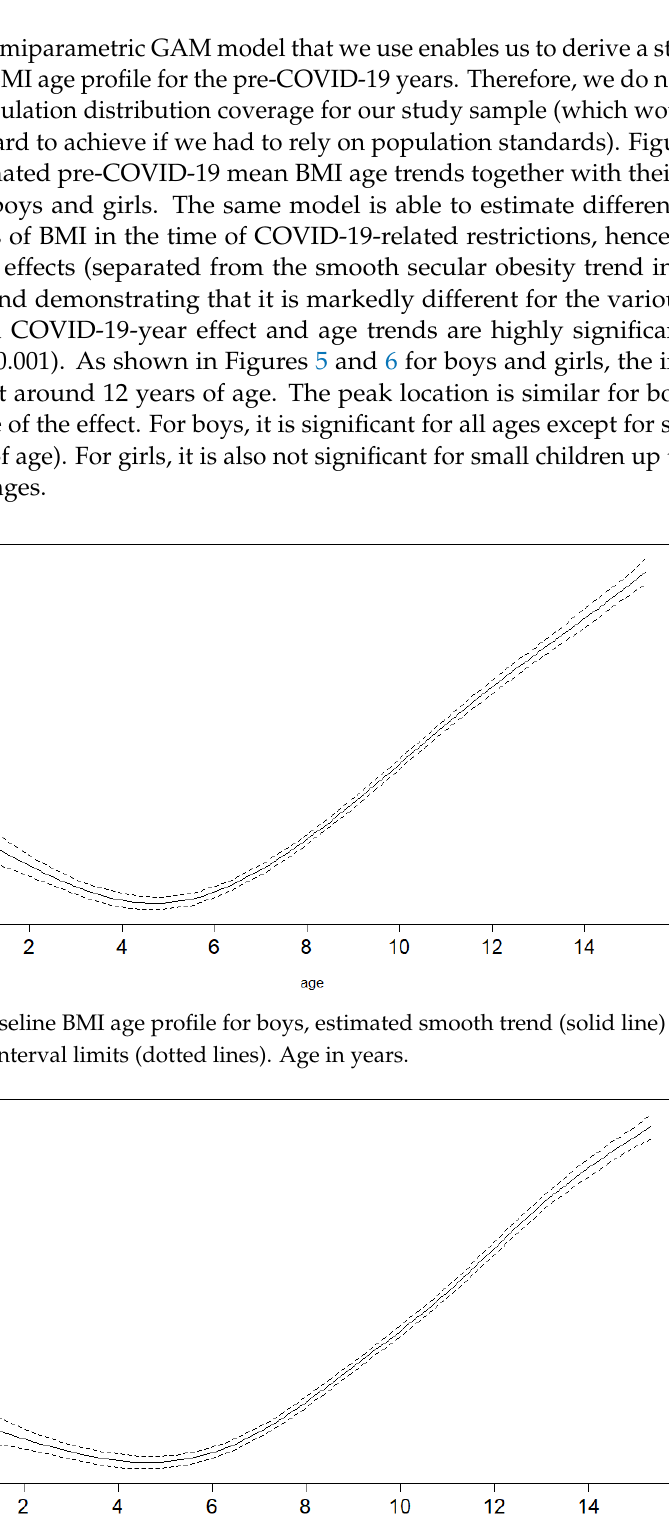
Figure 5. Differential COVID-19 year effect for different ages for boys, estimated smooth trend (solid line) and pointwise 95% confidence interval limits (dotted lines). Age in years. Figure 6. Differential COVID-19-year effect for different ages in girls, estimated smooth trend (solid line) and pointwise 95% confidence interval limits (dotted lines). Age in years.